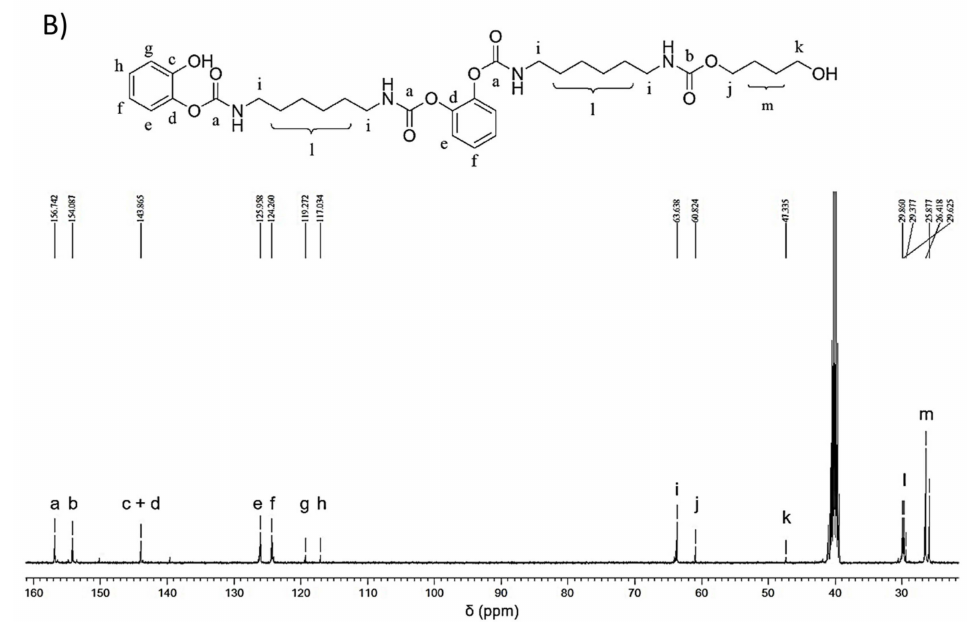
Figure 4. ( A ) 1 H (400 MHz) and ( B ) 13 C NMR (100 MHz) spectra in DMSO- d 6 of PU obtained by reacting 1,2-catechol, 1,4-butanediol, and hexamethylene